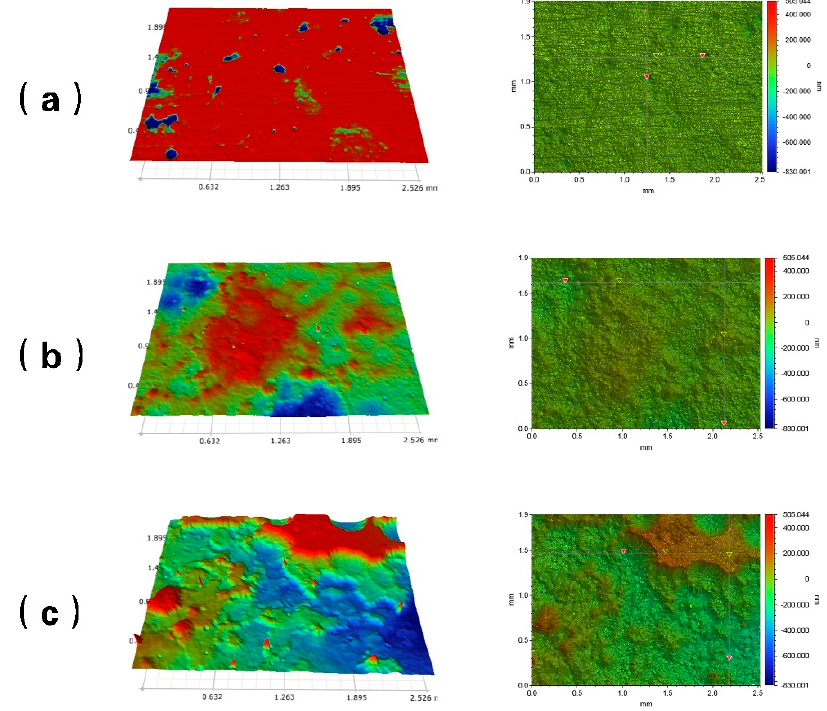
Figure 5. Macro topographies of the coupons after flow loop tests at 20 °C ( a ), 50 °C ( b ), and 60 °C ( c ).